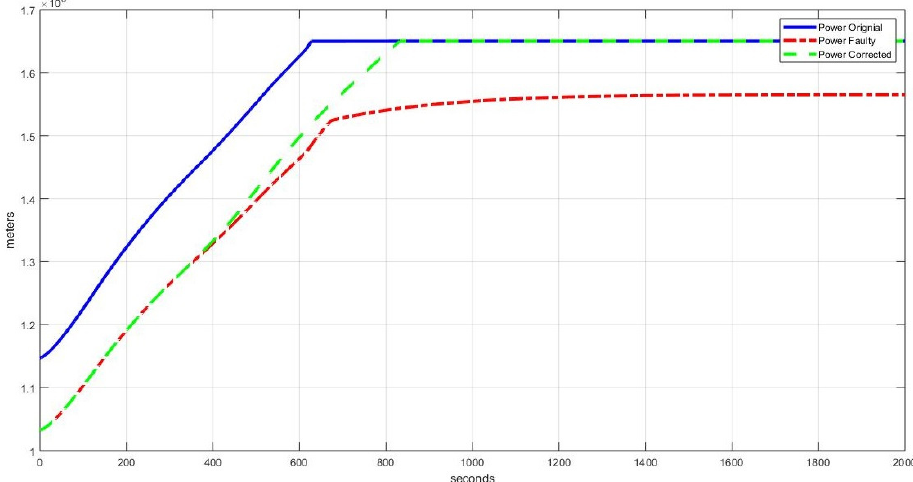
Figure 21. Pond 0 with normal, faulty, and fault-corrected operation given a turbine gate 𝐺 saturation fault.